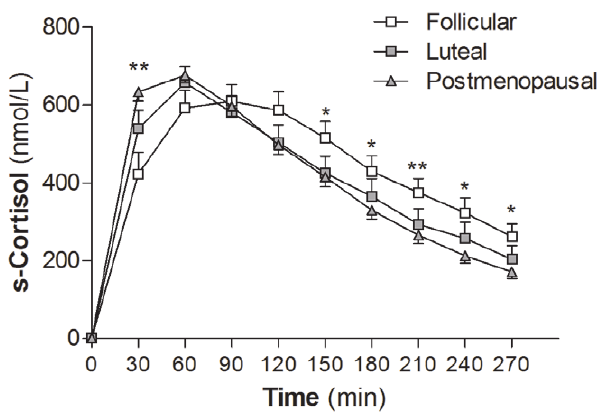
Figure 2. Hepatic 11 b HSD1 activity. Serum cortisol levels after overnight dexamethasone suppression and oral cortisone intake (25 mg). Postmenopausal women ( m , N=23) had higher serum cortisol levels at 30 min post cortisone intake than premenopausal women in follicular phase of the menstrual cycle ( % , N=17). * P , 0.05 and ** P , 0.01 for postmenopausal vs. premenopausal follicular phase. Luteal phase, & , N=16. Data are means 6 SEM.